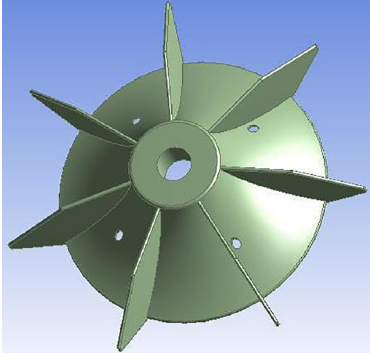
Figure 12. 3D ‐ printed radial cooling fan with optimized blades, reproduced with permission from Figure 12. 3D-printed radial cooling fan with optimized blades, reproduced with permission [147]. Copyright Elsevier 2018. from [147]. Copyright Elsevier